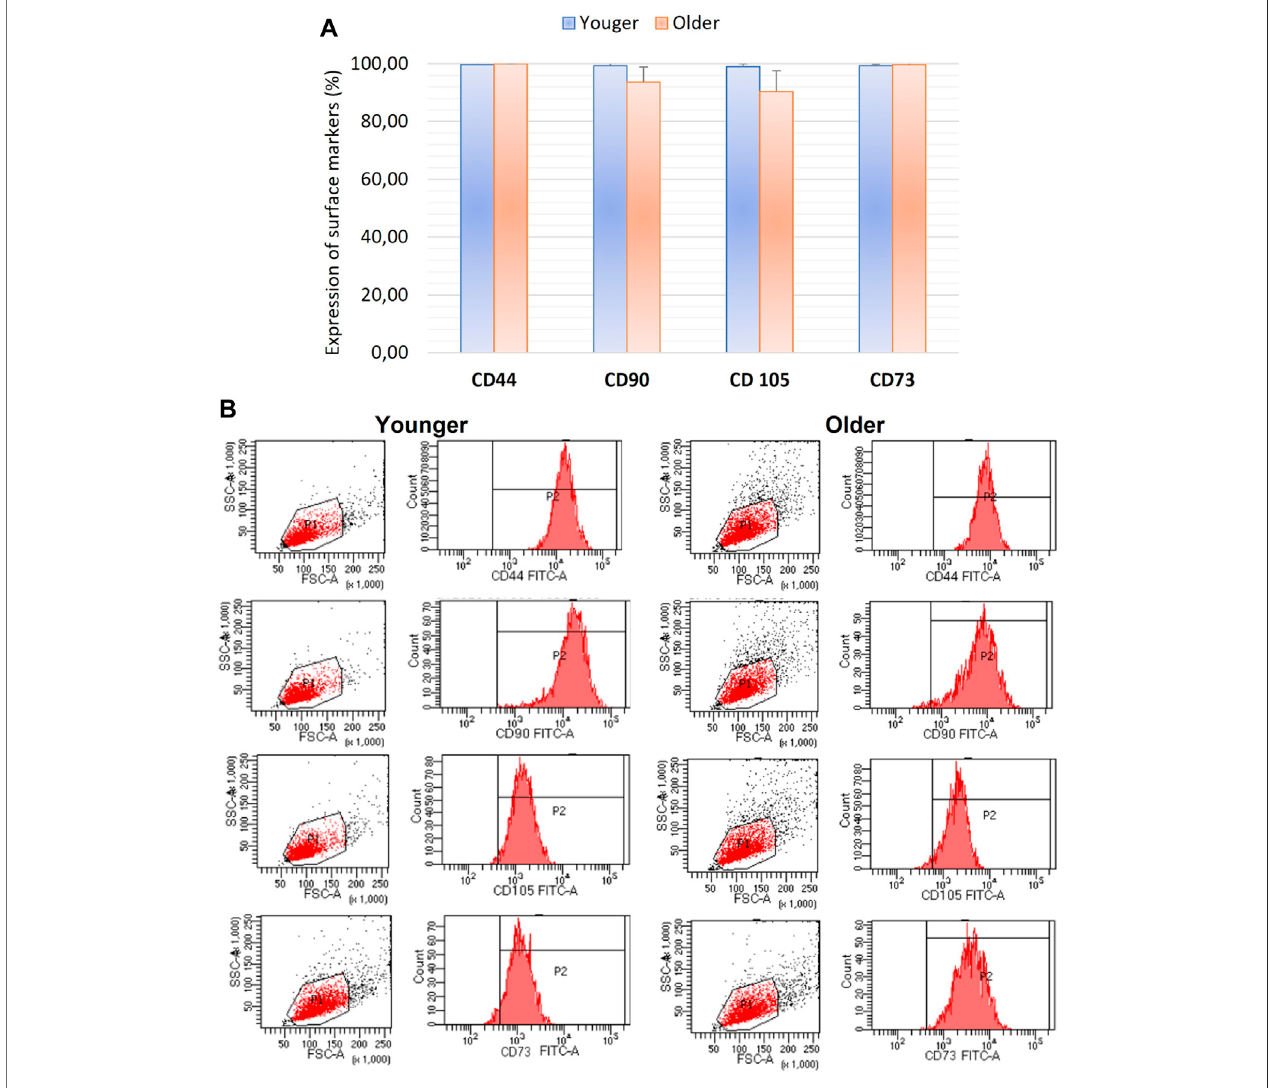
FIGURE 5 | (A) Comparison of MSCs ’ surface markers expression CD44, CD90, CD105, and CD73 for BMAs clot from younger and older donors; (B) representative histogram of the fl ow cytometry analysis (FACS) of the MSC-related CD surface markers in BMAs clot from younger and older donors. (A) and (B) demonstrated high positive expression of CD44, CD90, CD105, and CD73 in both MSCs from BMAs clot from younger and older donors.